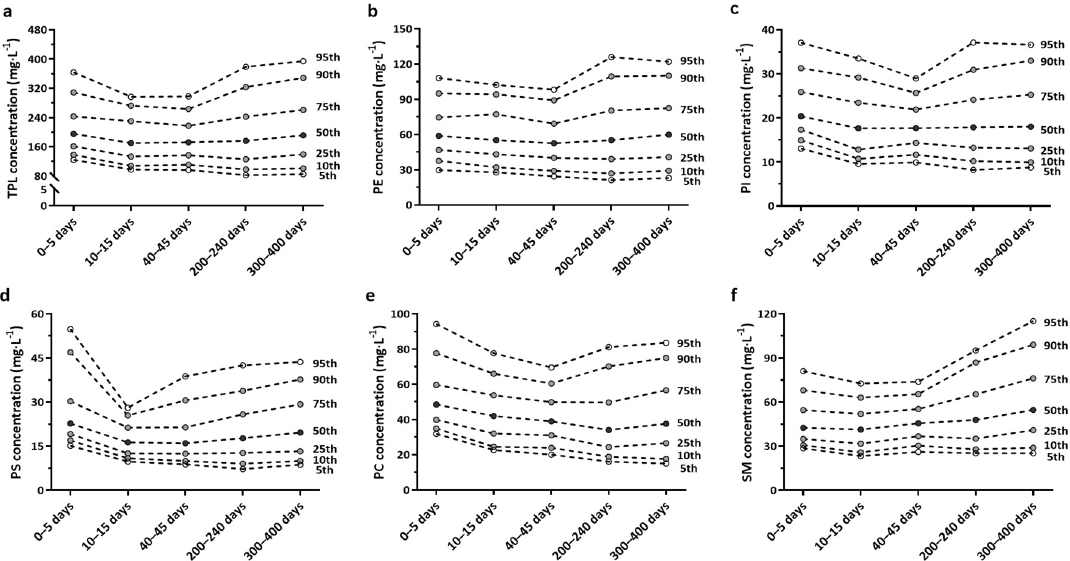
Figure 1. The percentile values of TPL concentration ( a ), PE concentration ( b ), PI concentration ( c ), PS concentration ( d ), PC concentration ( e ) and SM concentration ( f ) over lactation are shown. PC, phosphatidylcholine; PE, phosphatidylethanolamine; PI, phosphatidylinositol; PS, phosphatidylserine; SM, sphingomyelin; TPL, total phospholipid.